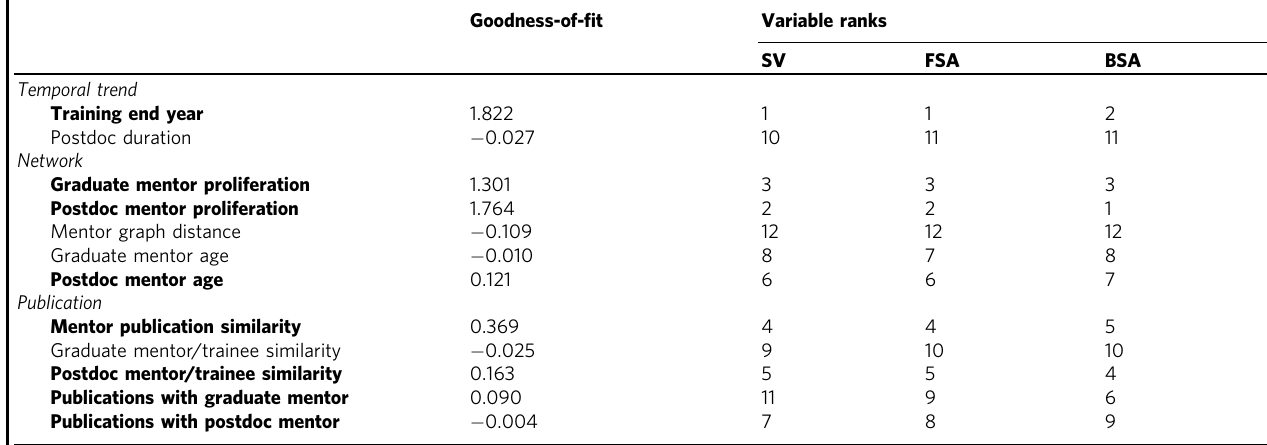
Table 1 Overview of factors impacting trainee proliferation and their contribution to the model ’ s goodness-of- fi t Goodness-of- fi